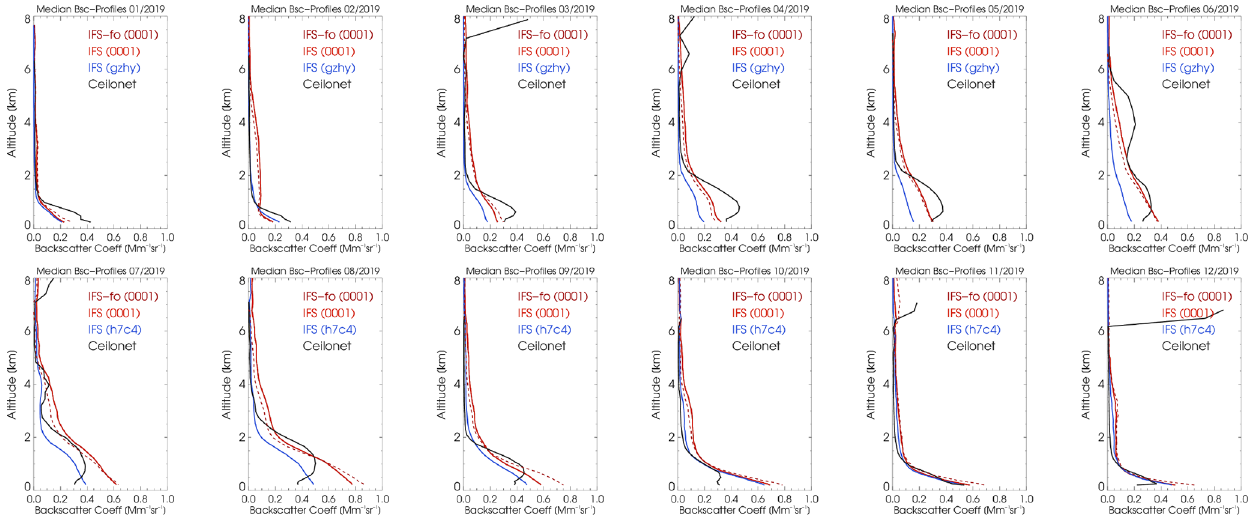
Figure D4. Monthly median profiles 2019 from the ceilometer (black), ASM (red) and control run (blue). The median profile from the IFS forward operator is added as a dashed red